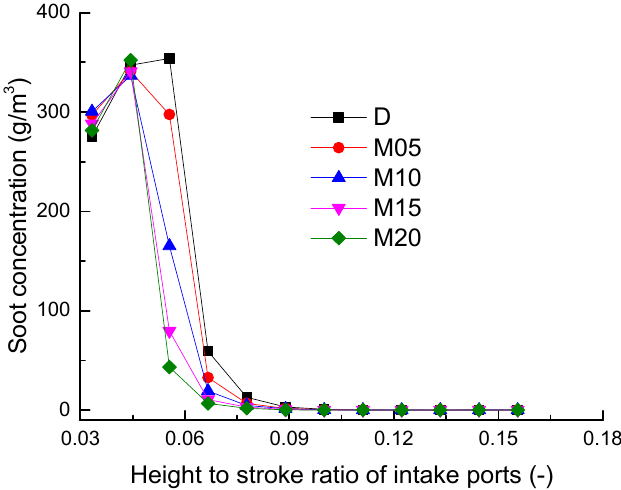
Figure 6. Soot concentration under different HSRs of intake ports.